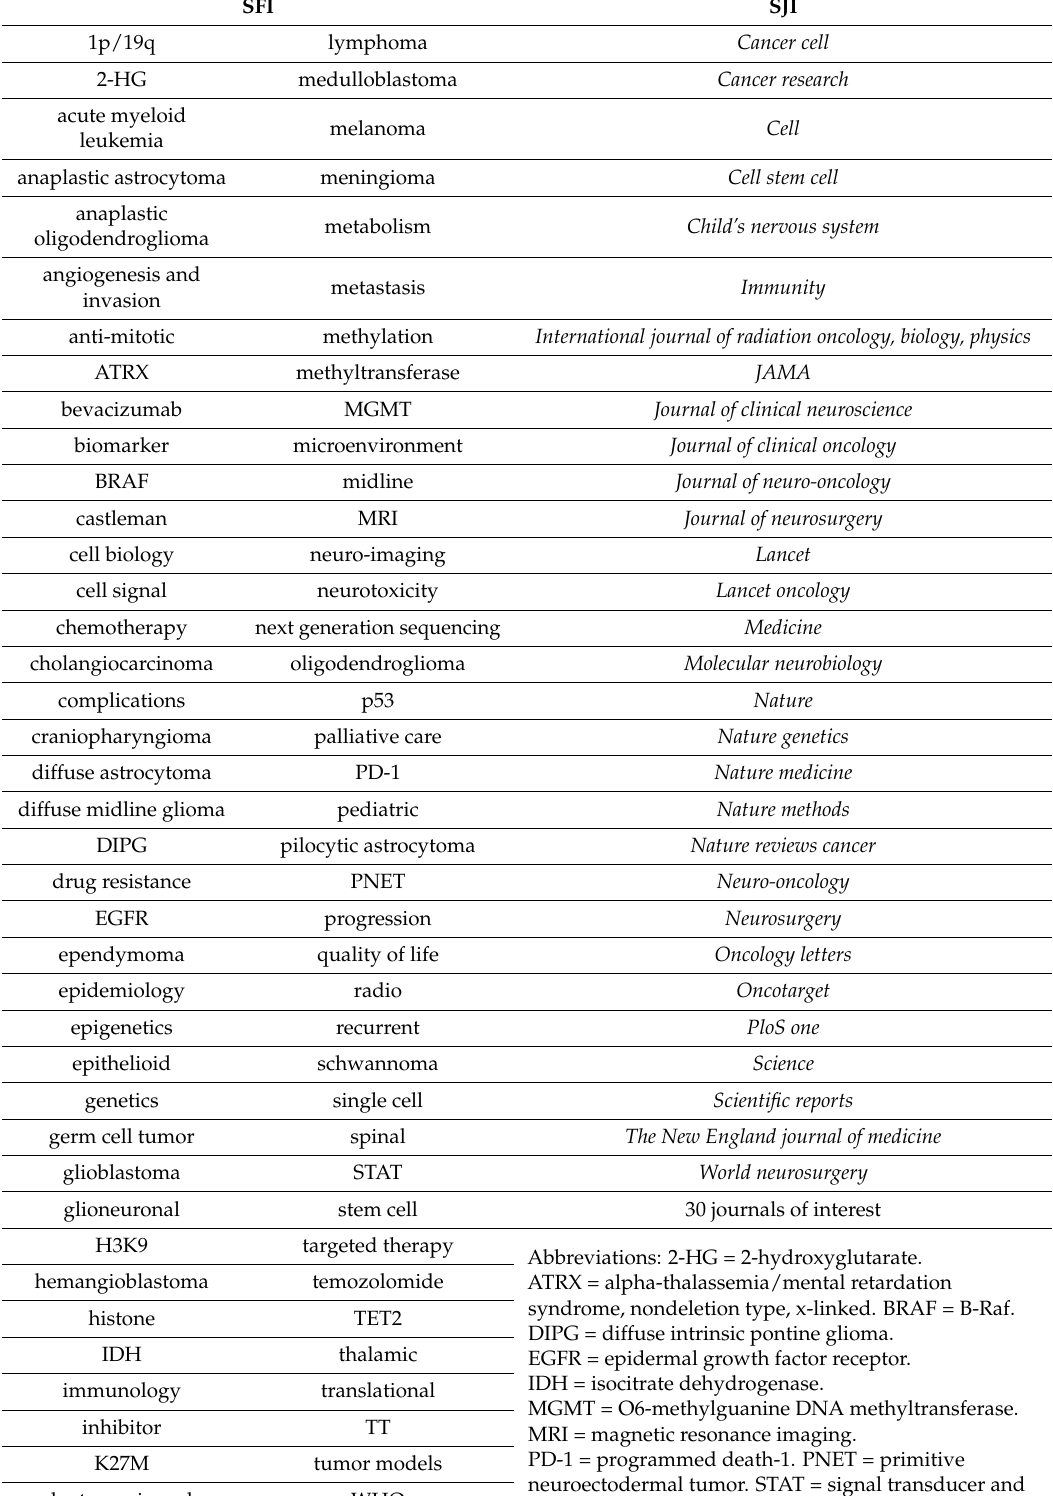
Table 1. Seventy-nine keywords of SFI and 30 journals of SJI.